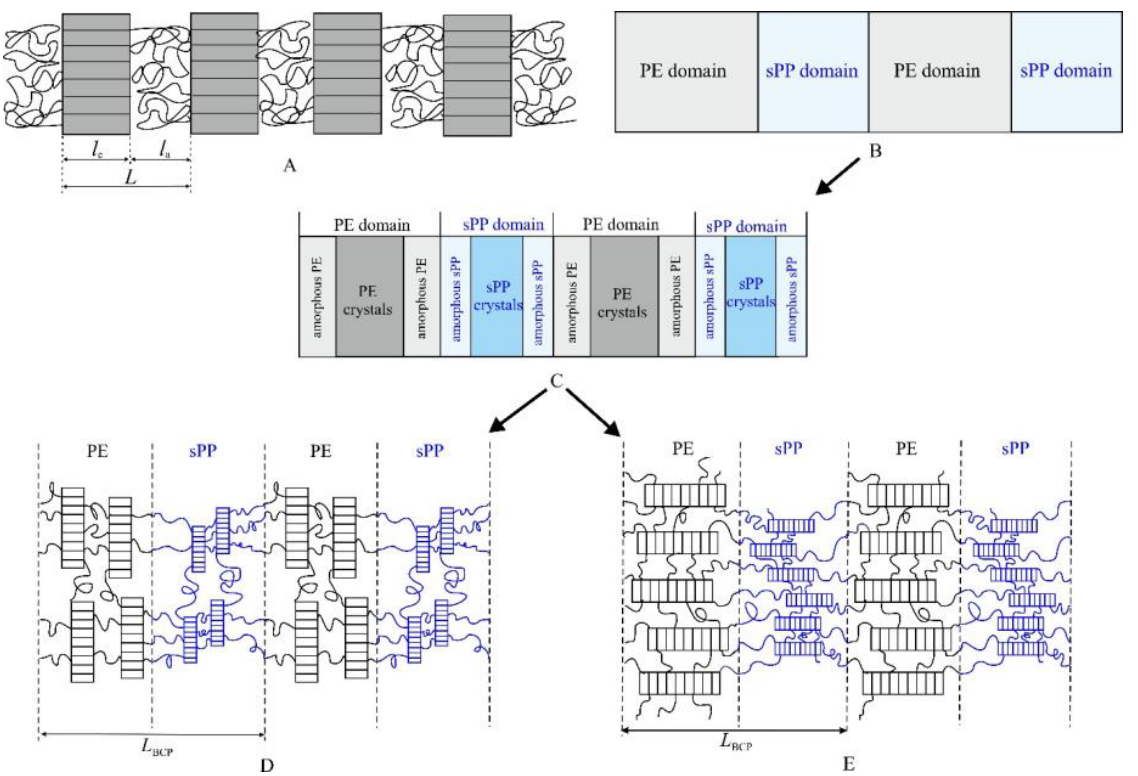
Figure 6. Schematic models of morphology that may develop in the sample PE-b-sPP-1 with f sPP = 53%, based on SAXS profiles of Figure 5. ( A ) Stacks of crystalline lamellae of PE and/or sPP alternating with amorphous chains; ( B ) Possible lamellar morphology of the nearly symmetric BCP in the melt with alternating amorphous lamellar domains of PE and sPP; ( C ) Possible morphology that develops upon cooling from the melt, characterized by alternating sPP and PE domains, which include stacks of crystalline lamellae of sPP and PE, respectively, separated by the corresponding amorphous regions of sPP and PE; ( D , E ) Details of the morphology in C showing two possible limit orientations of the chain axes in the crystalline domains, normal ( D ) and parallel ( E ) to the lamellar domain interface ( D ).